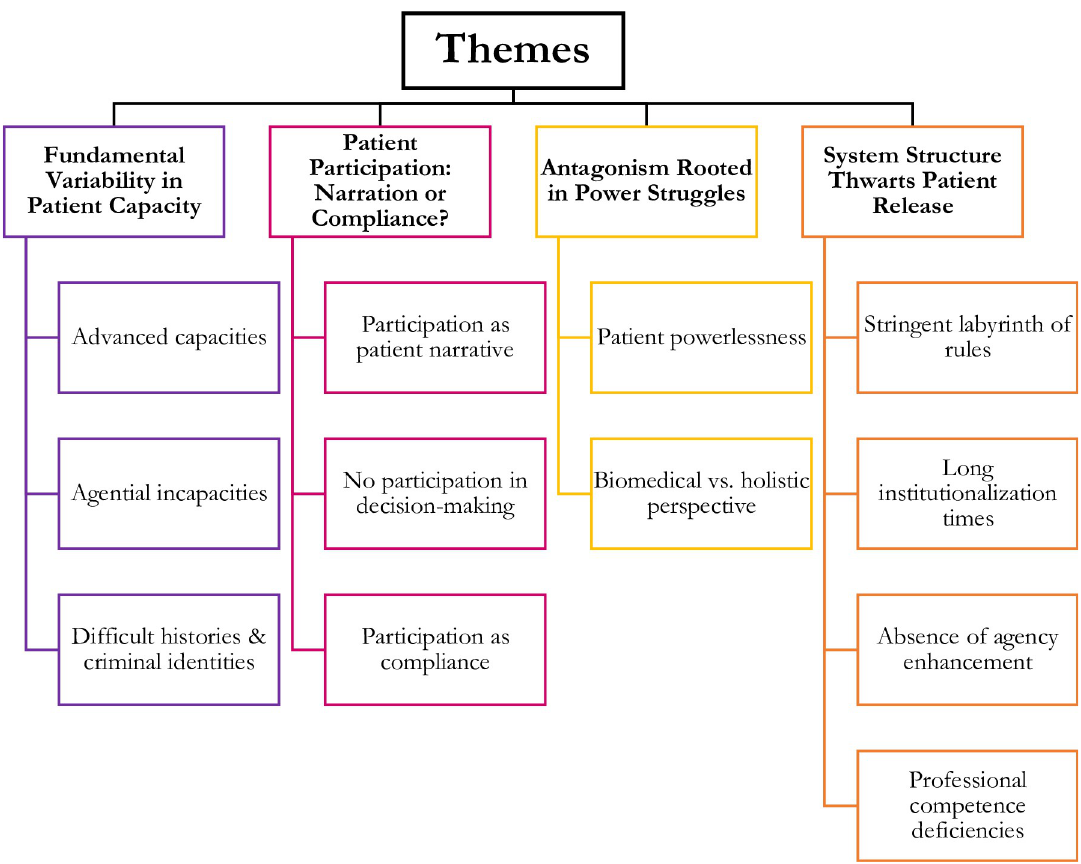
Fig 2. A tree diagram representing the four themes and their